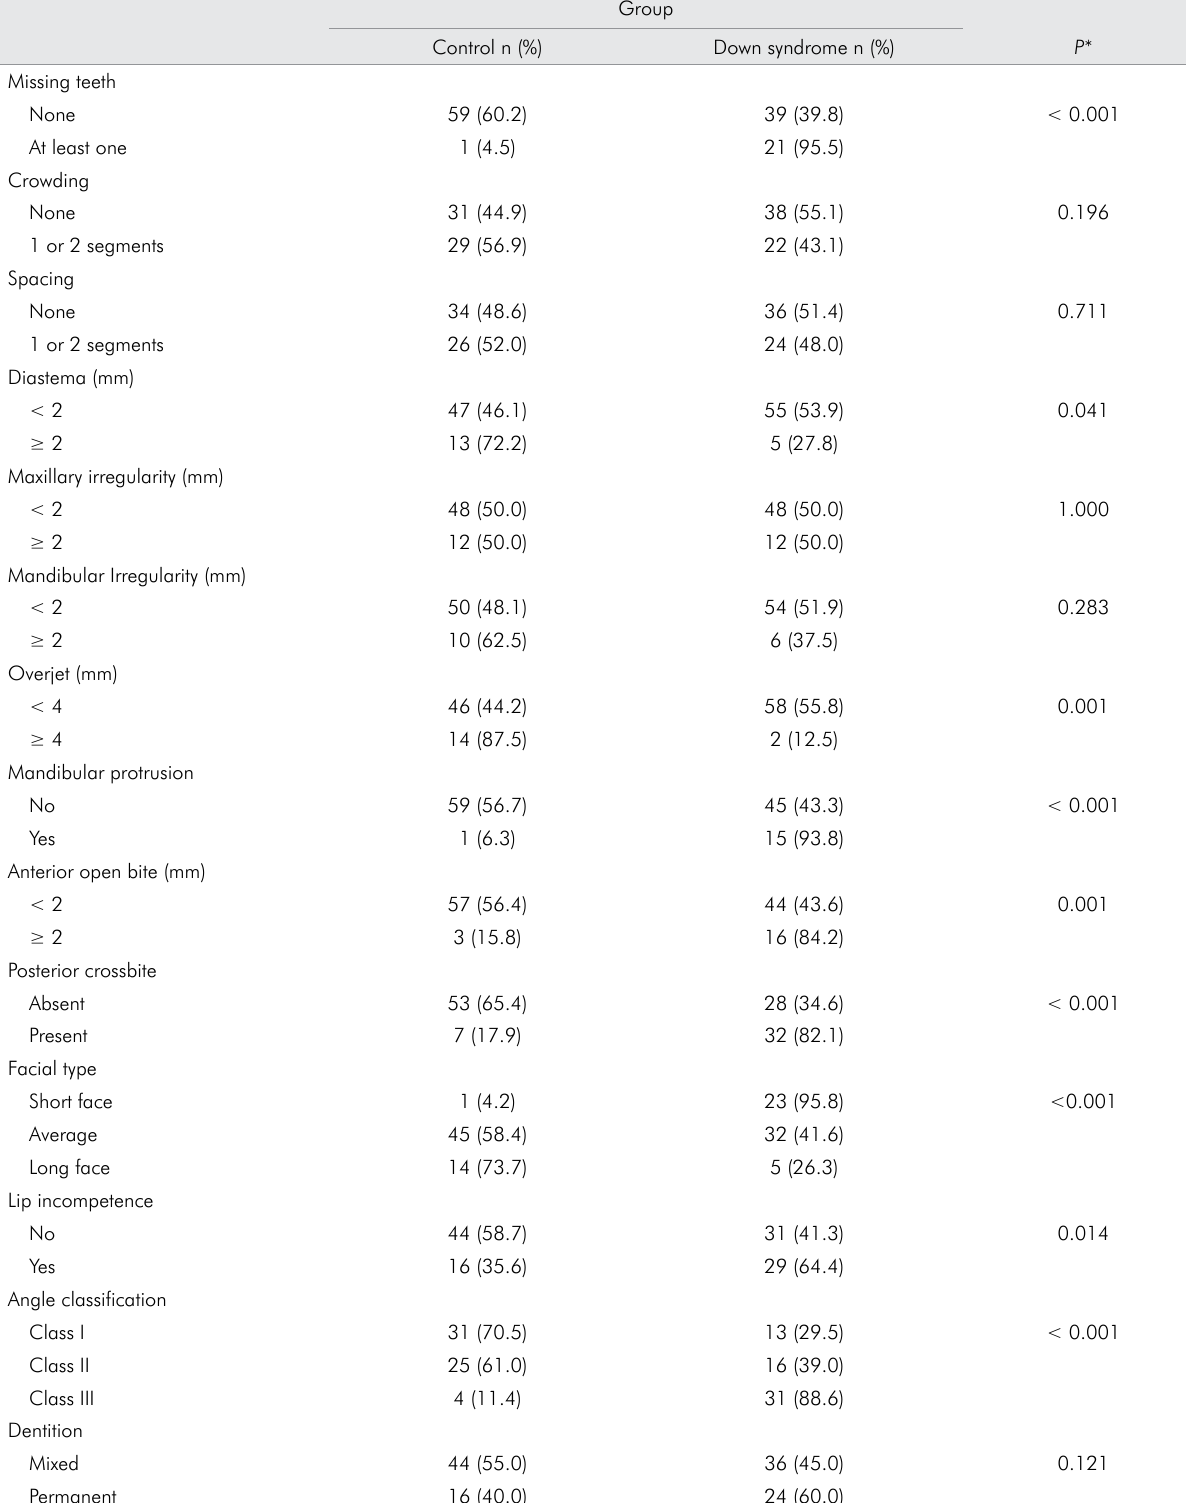
Table 1. Univariate analysis considering aspects related to malocclusion in the Down syndrome group and control group without mental